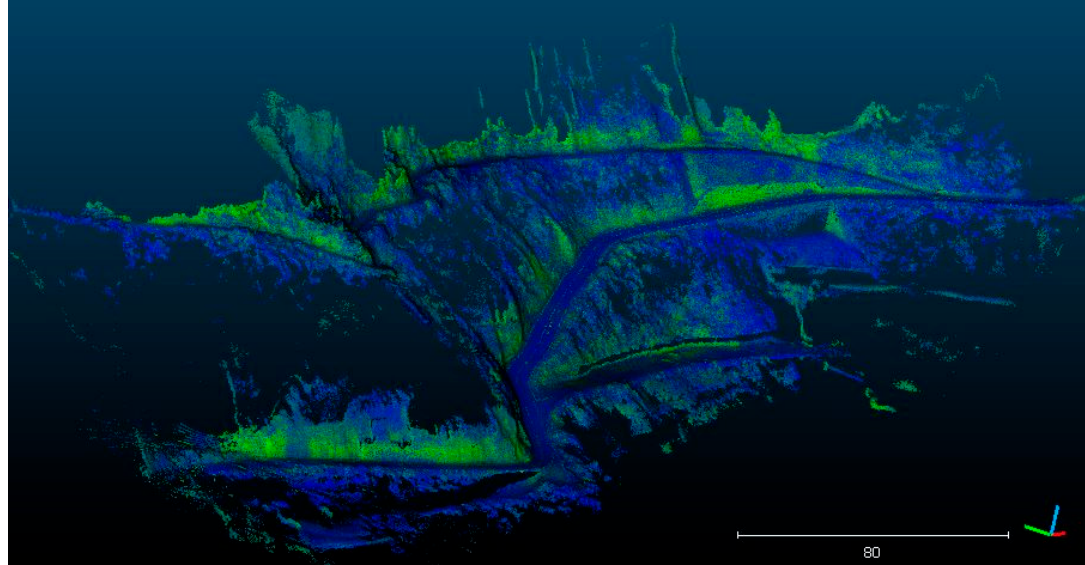
Figure 9. Cortes de Pallás MMS point cloud: the result of filtering algorithm CSF (Cloth Simulation Filter), applying the shader filter EDL (Eye Dome Lighting) which help to show better the topography of the study area .